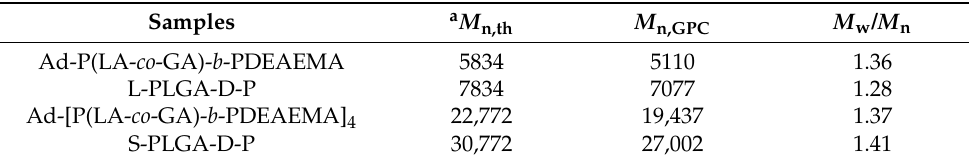
Table 1. Molecular weights and distributions of polymers. Samples